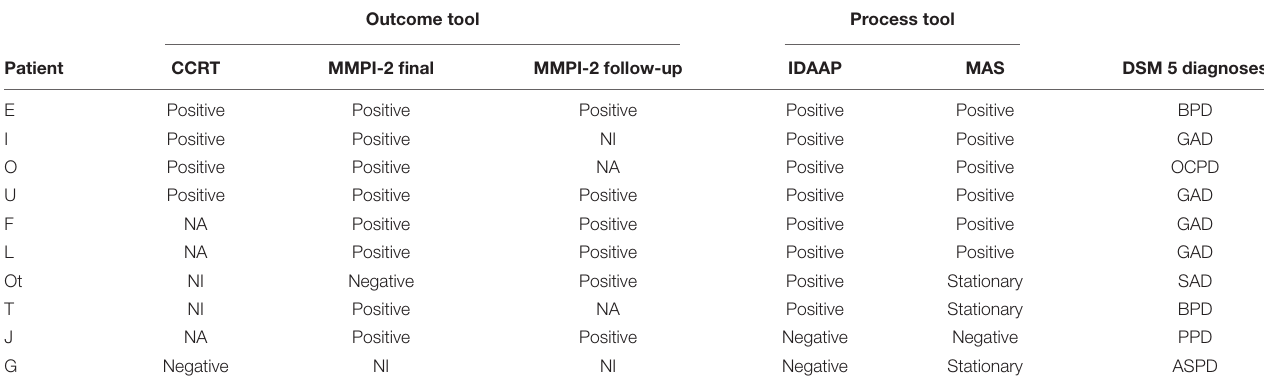
TABLE 7 | Data concerning patients’ overall scores for each used